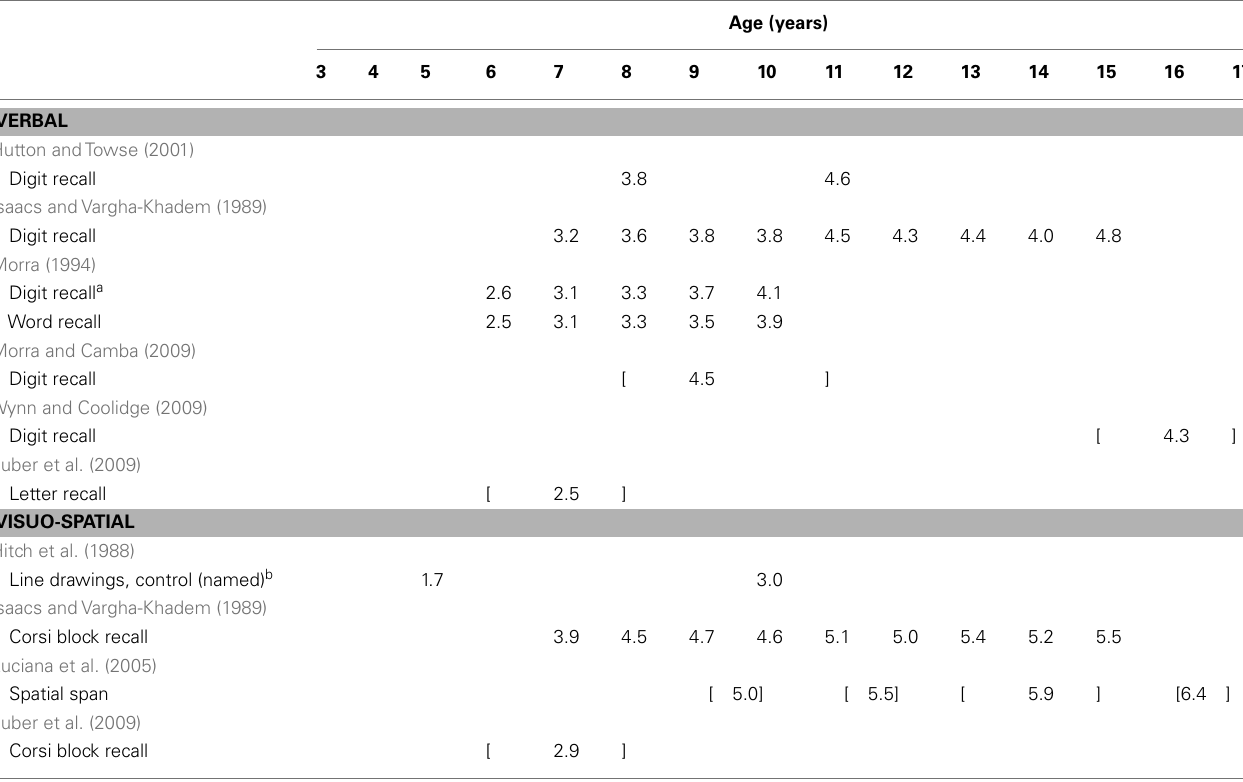
Table 3 | Estimates of working memory capacity using backward span